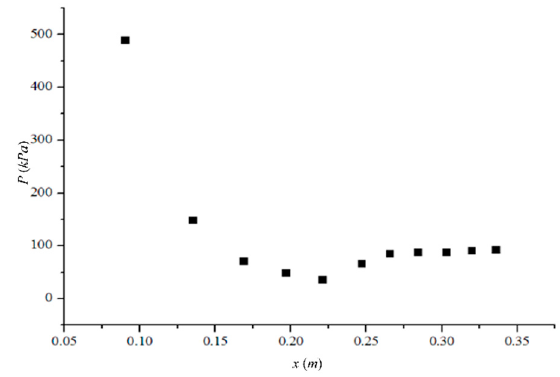
Figure 5. Test-measured wall pressure, Pc = 4.34 MPa.